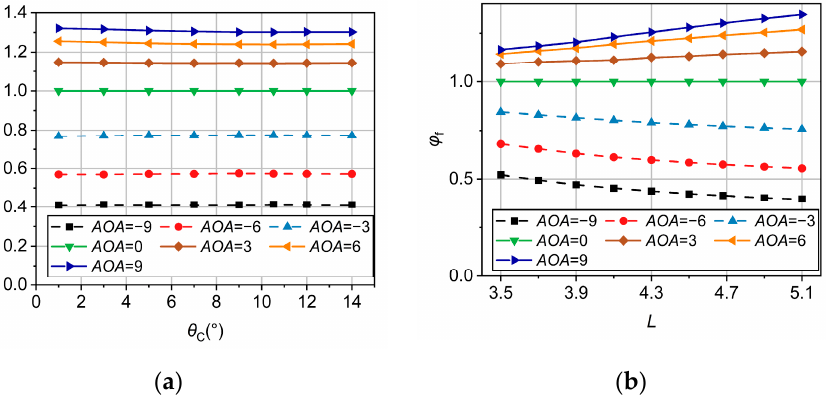
Figure 9. Evolution of the mass capture ratio at off-design AOA with varying ( a ) the cowl internal angle; and ( b ) the cowl internal angle.